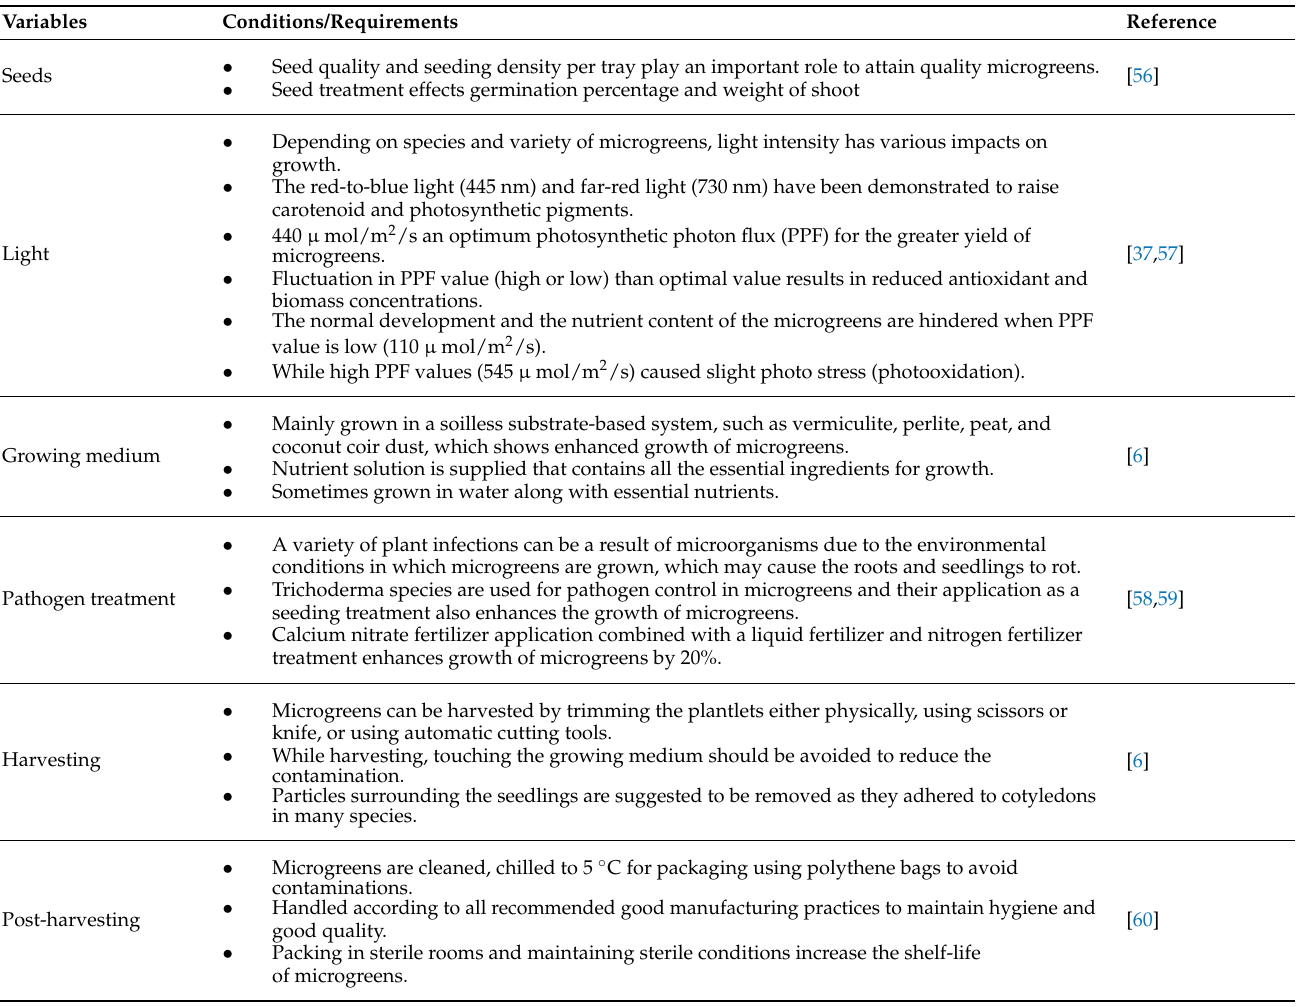
Table 3. Important conditions/requirements considered for growing